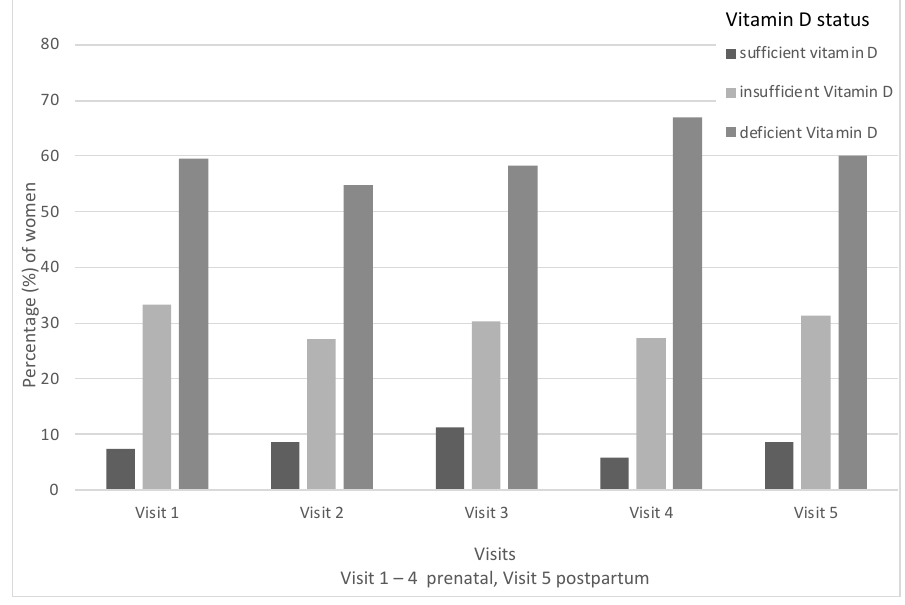
Figure 1. Vitamin D status over the course of pregnancy and postpartum.